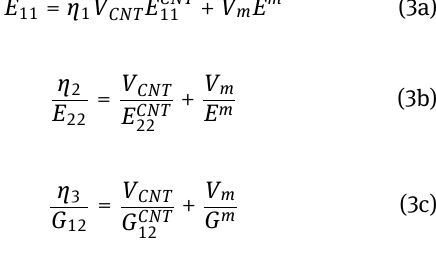
corner and on the middle surface of shell panel, x and y are